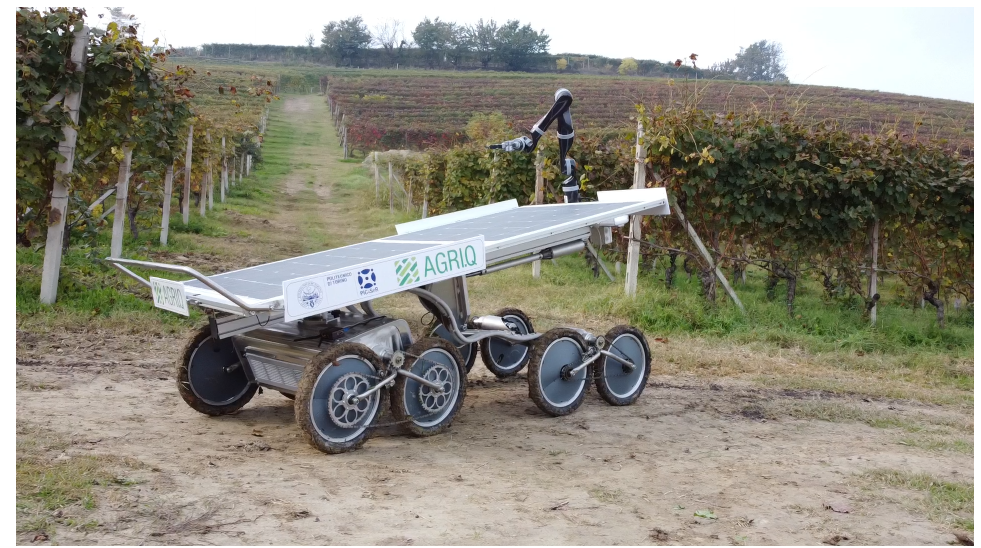
Figure 5. Agri.Q in a vineyard in Castagnito, part of the Roero historical region in the south of the Italian region